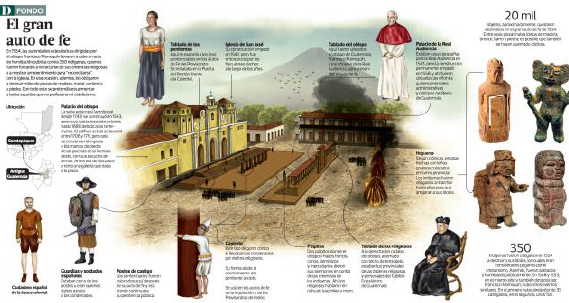
Figure. 15. Ilustrations created based on the HRS. Revista Prensa Libre , No. 784, Guatemala, August 18,